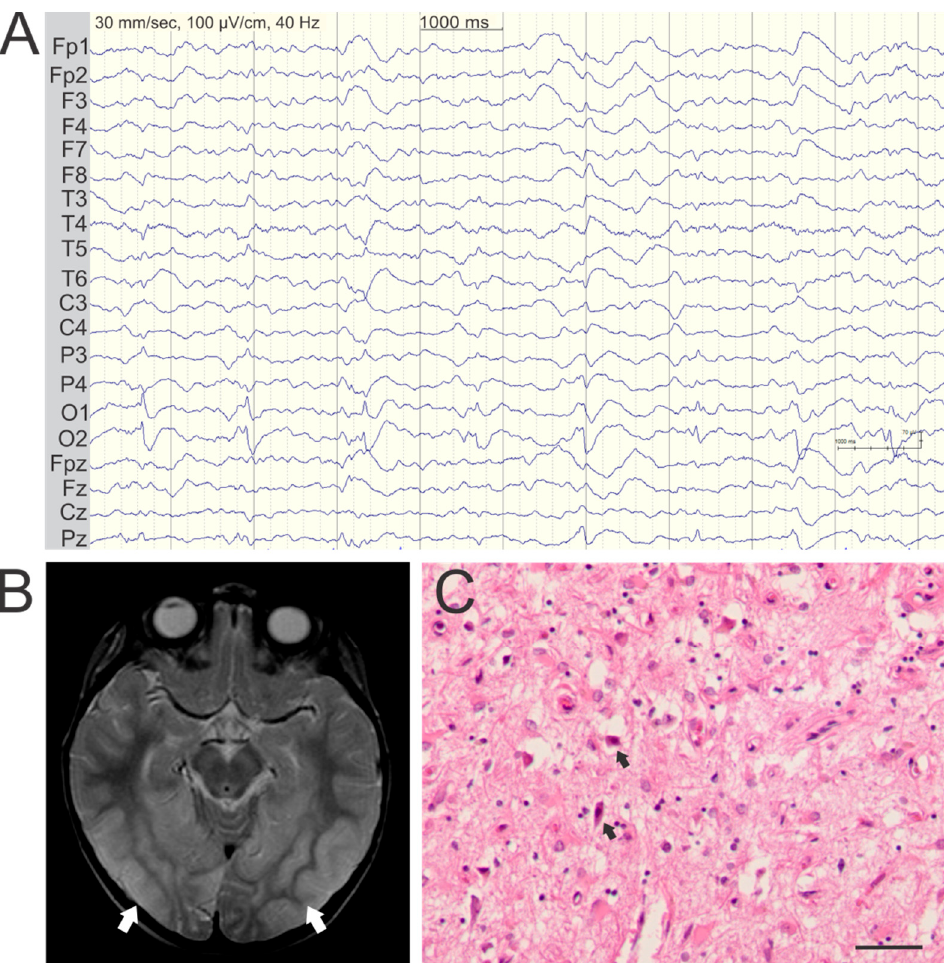
Figure 2. Typical EEG, imaging, and neuropathology in POLG encephalopathy. Representative findings are shown from a 41-year-old patient, homozygous for the p.W748S mutation (EEG and histology) and an 8-year-old patient compound heterozygous in trans for the p.A467T and p.G303R (MRI). ( A ) Interictal EEG recording showing periodic sharp activity around 1Hz frequency in in occipital leads O1 and O2; ( B ) Axial T2-weighted MRI shows bilateral high T2-signal consistent with cortical edema, in the occipitotemporal regions (white arrows); ( C ) Hematoxylin and eosin stained section of the medial occipital cortex showing severe vacuolation of the neuropil and neuronal loss. Arrows mark examples of eosinophilic neuronal necrosis (magnification: 200×, scalebar: 50 µm).